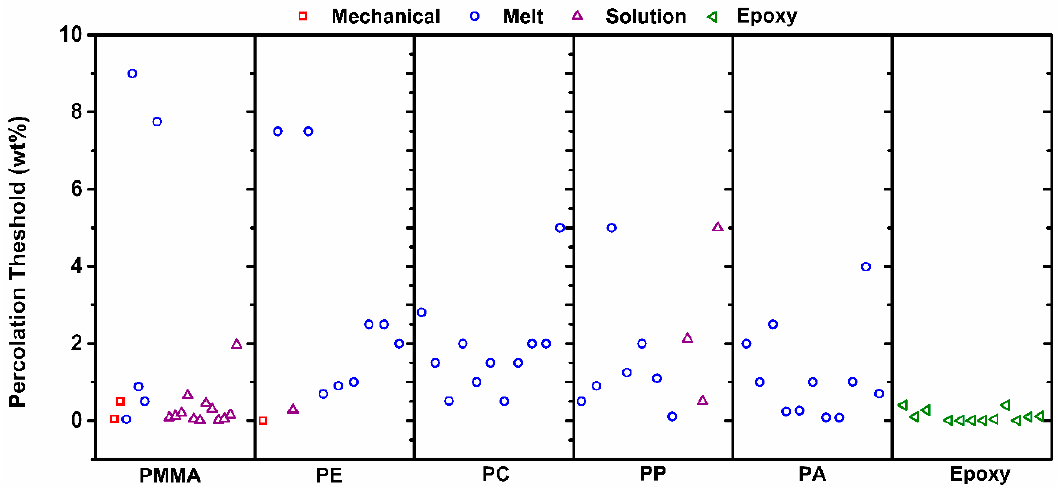
Figure 11. Percolation thresholds for several carbon nanotube/polymer composites with different processing conditions [1,3,9,15,17–57]. For more details about individual points, please see Table S1 in the supplementary file.